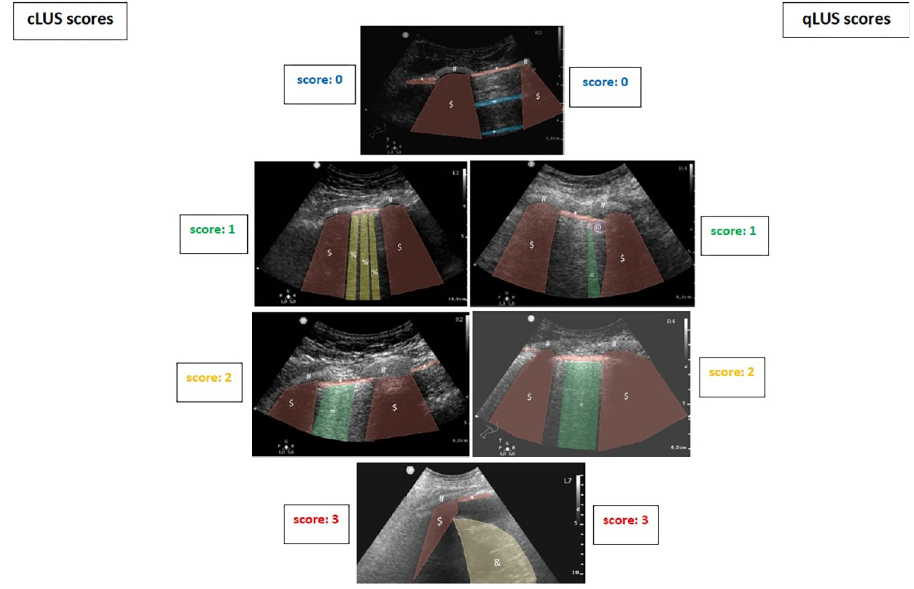
Fig 2. Representative images of scoring. Symbols in images $: rib shadow, � : pleural line, #: rib, %: B-lines, @: non- translobar consolidation, =: coalescent B-lines, &: tissue-like pattern (translobar consolidation).